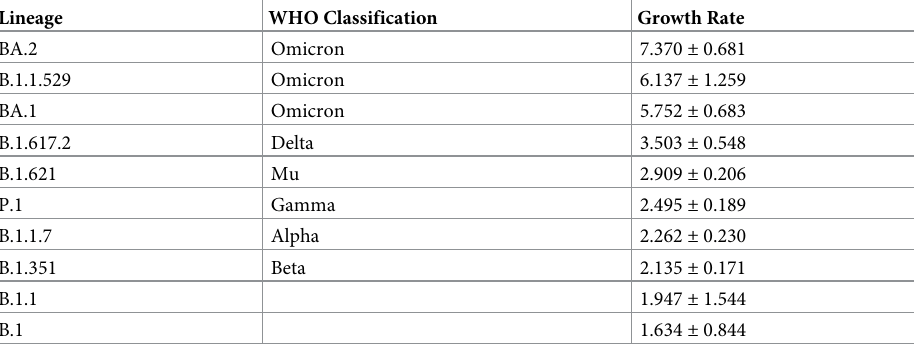
Table 2. Growth rates for selected SARS-CoV-2 lineages.